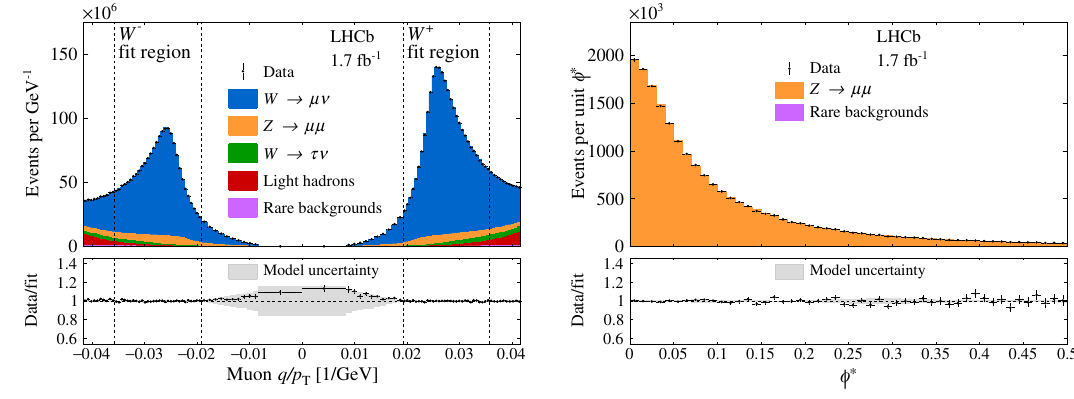
Figure 11 . Distributions of (left) q/p T and (right) φ ∗ compared to the model after the m W fit.